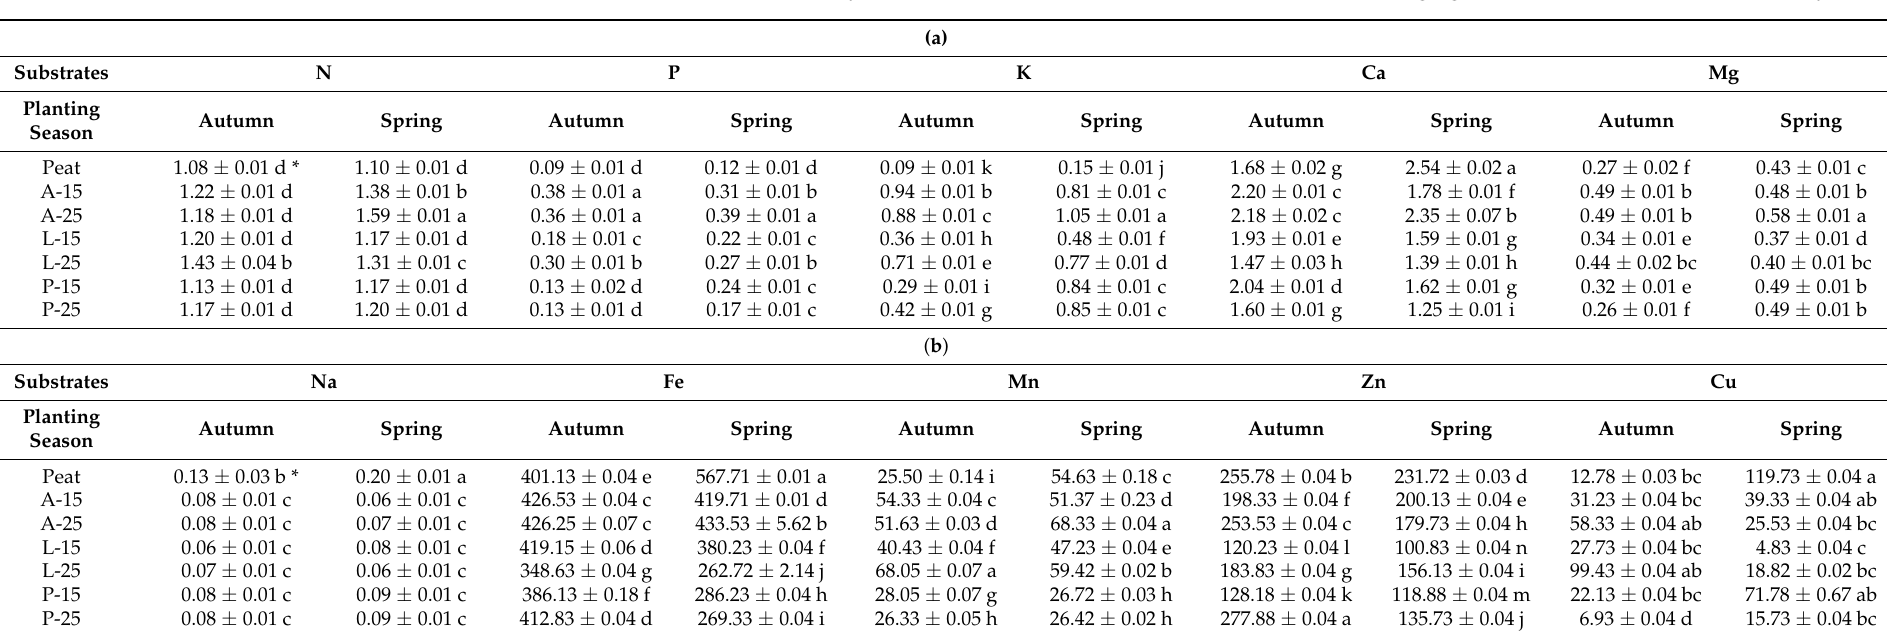
Table 14. ( a ) Macronutrient concentrations in strawberry roots (%DW). ( b ) Sodium (%DW) and micronutrient (mg · kg − 1 DW) concentrations in strawberry